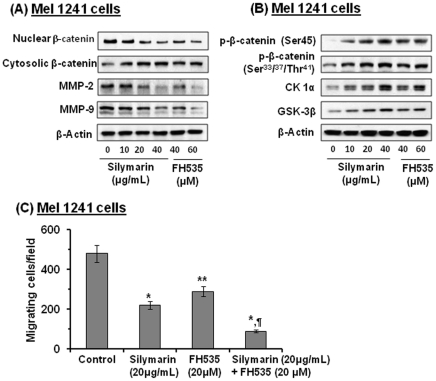
Effect of silymarin and FH535 on β-catenin and its signaling molecules in Mel 1241 cells.(A) Effect of silymarin and FH535 on the cytosolic and nuclear accumulation of β-catenin, and MMP-2 and MMP-9 in Mel 1241 cells. Cells were treated with silymarin or FH535 for 8 h then harvested, nuclear and cytosolic fractions were prepared and subjected to western blot analysis. (B) Effect of silymarin and FH535 on phosphorylation of β-catenin at “critical residues” and on the expression levels of regulatory kinases (GSK-3β, CK1α) implicated in activation of β-catenin. (C) The combined effect of silymarin and FH535 on Mel 1241 cell migration. Cells were treated with the indicated low doses of silymarin and FH535 either alone or in combination for 8 h and cell migration was determined using invasion assay. Cell migration data are expressed as the mean number of migratory cells ±SD per microscopic field (n = 3). Significant inhibition versus untreated control, *
P<0.001, *
P<0.01. Significant inhibition versus either agent alone, ¶
P<0.01.